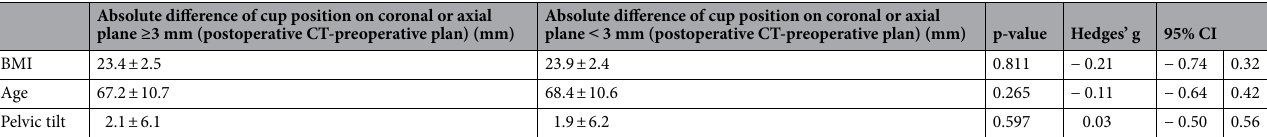
Table 6. Results of 3D cup position accuracy.